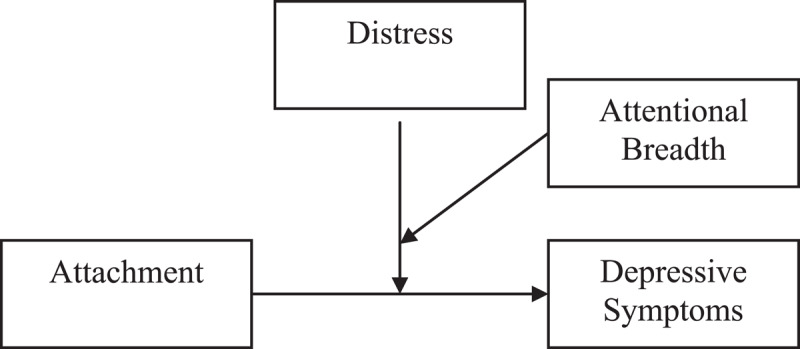
Theoretical Model.